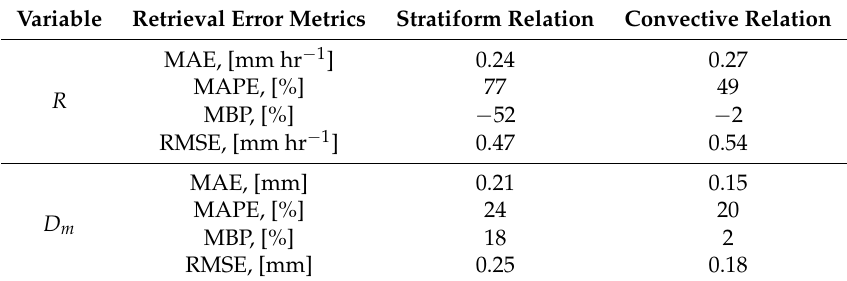
Table 4. Error metrics from the snowfall data measured in